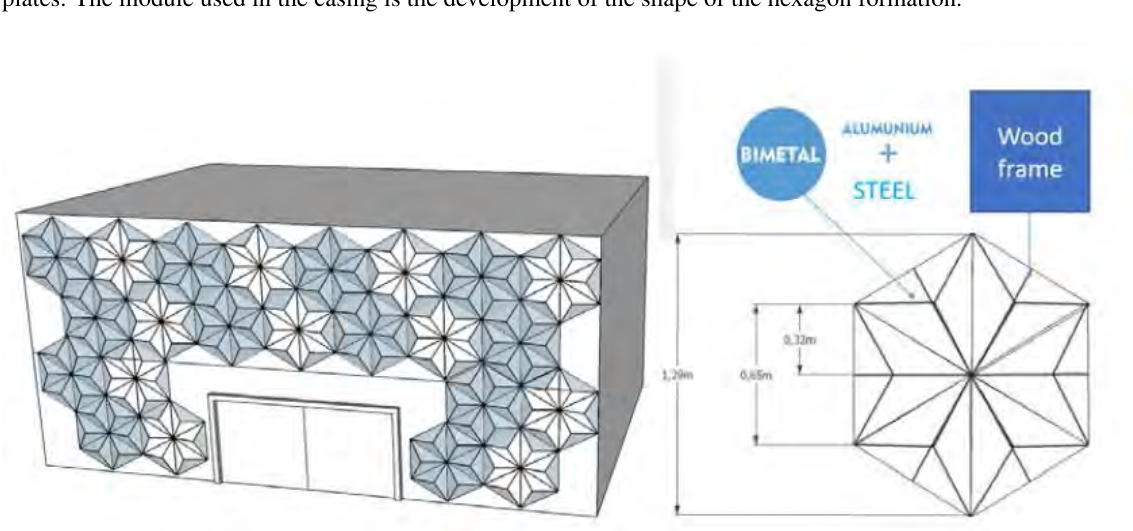
Figure 2. Parametric Module of Thermal